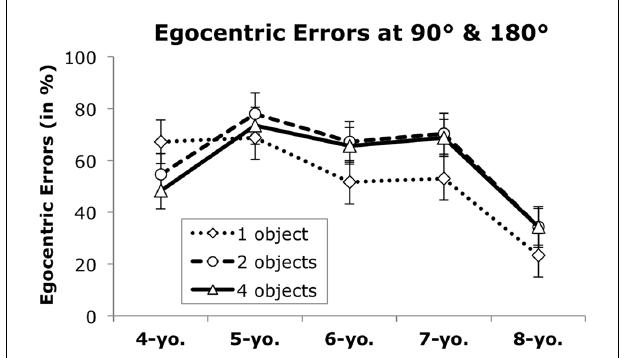
FIGURE 4 | Mean egocentric errors (in %) in trials requiring a perspective change, by age group and number of objects. Error bars indicate the standard error of the